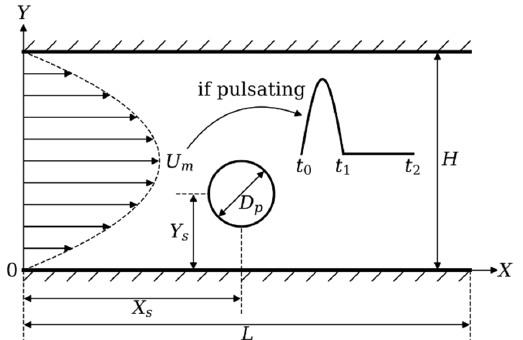
Figure 3. Configuration of a particle migrating in Poiseuille channel flow. The origin coordinate locates at left down corner, X in horizontal direction and Y in vertical direction. The simulation domain size is fixed as L × H , while the particle is located at [ X s , Y s ] initially. The diameter of the particle is D p , U m represents the maximum velocity. For pulsatile case, U m will change by